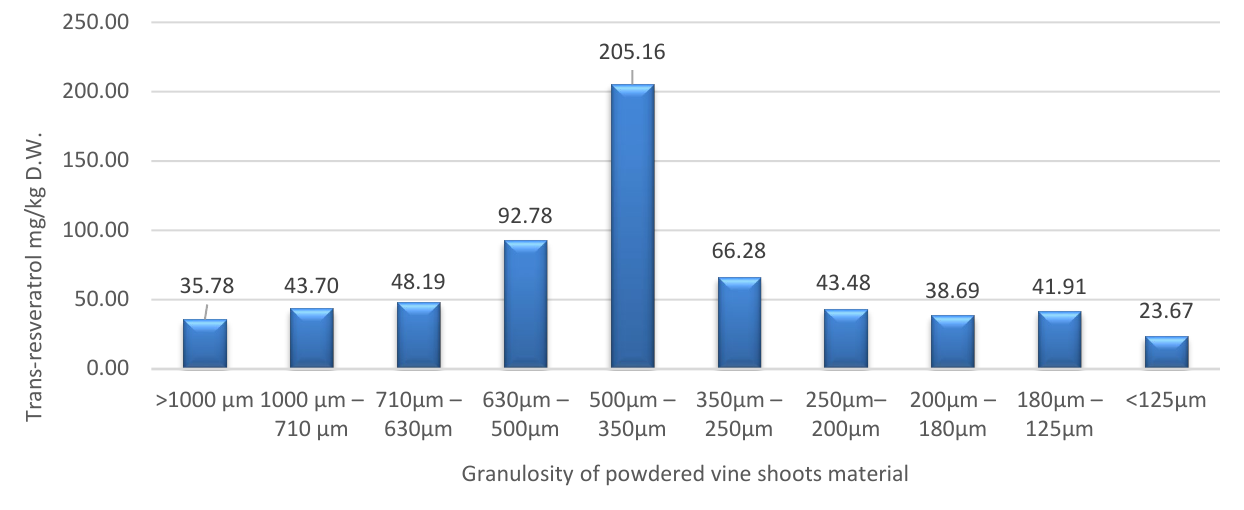
Figure 4. Extraction yield of resveratrol for different granulosity of the powdered material of vine shoots.